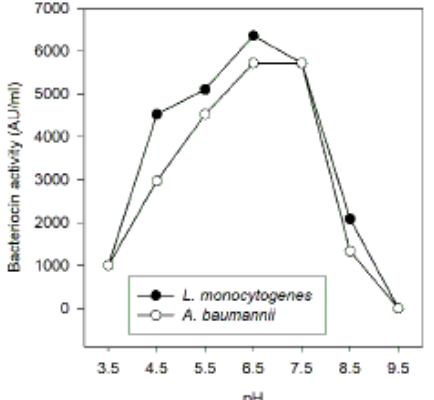
Fig. 9. Effect of pH on partially purified bacteriocin activity